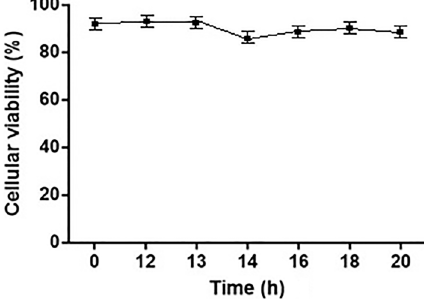
Figure 1. Cellular viability of human lymphocyte-rich peripheral blood mononuclear cells, determined using the Trypan Blue dye exclusion method, over a 20-h period (n=3). The data are reported as means ±